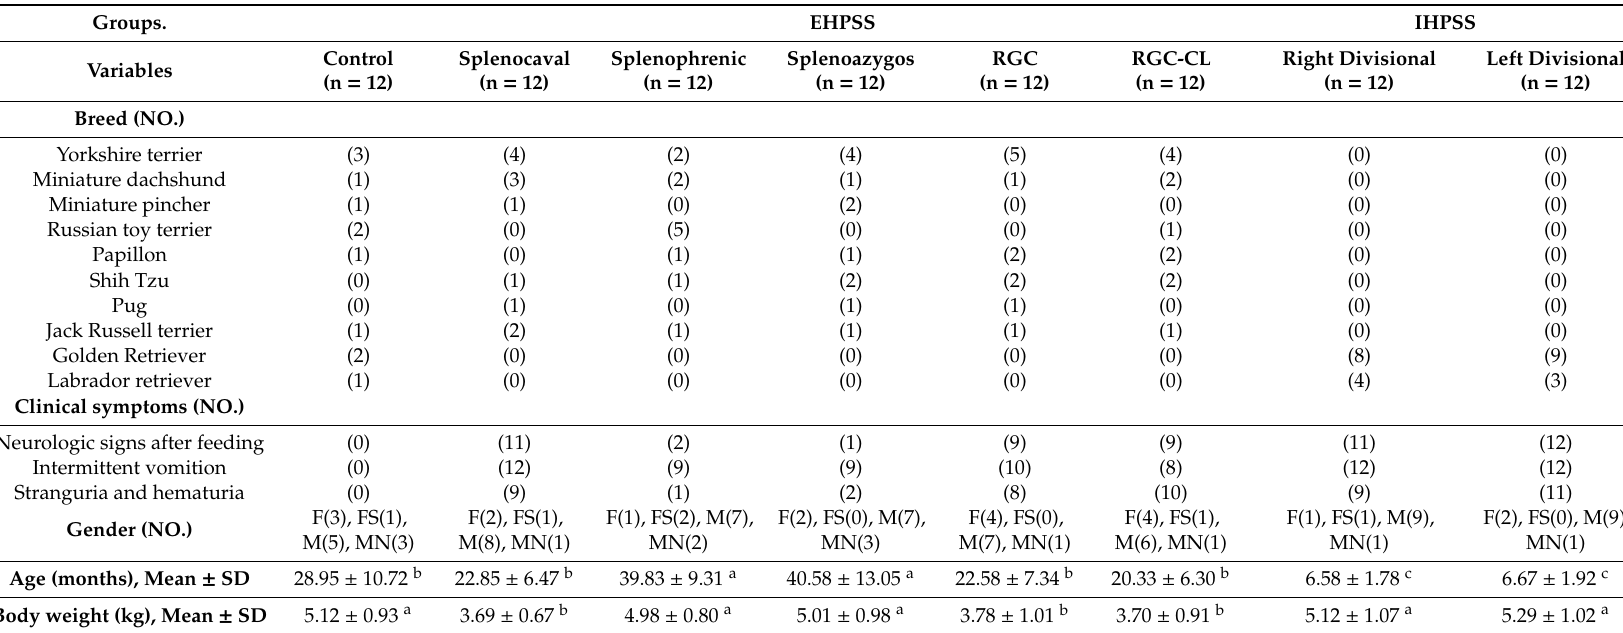
Table 1. Dog characteristics included in the